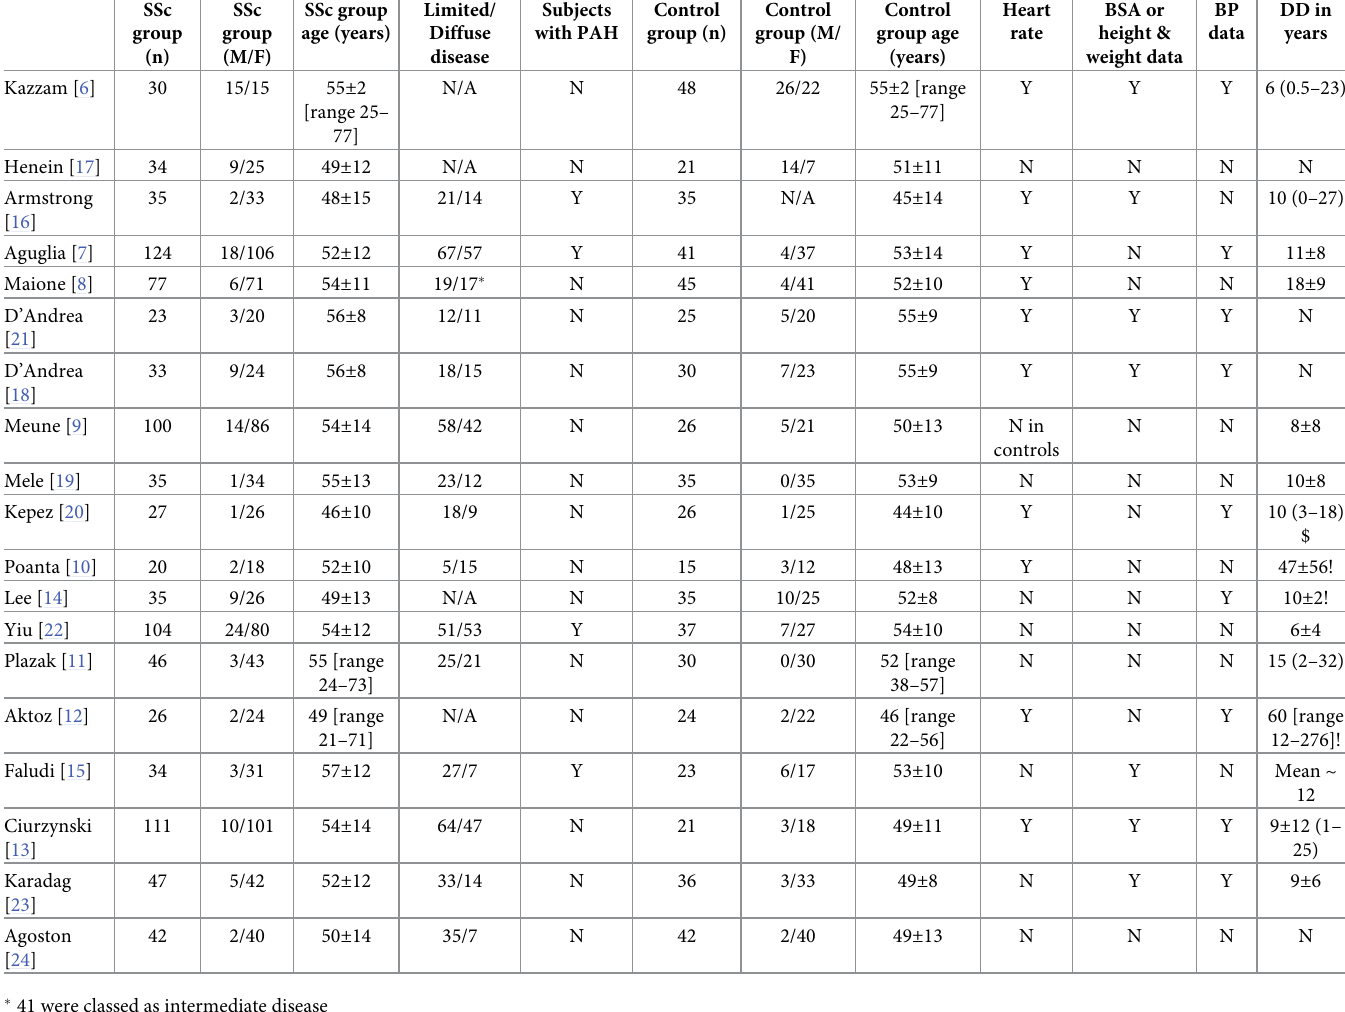
Table 6. A summary of the subject characteristics and available demographic data in a selection of systemic sclerosis echocardiographic studies in which LV struc- tural or filling variables or long-axis velocities have been compared to control